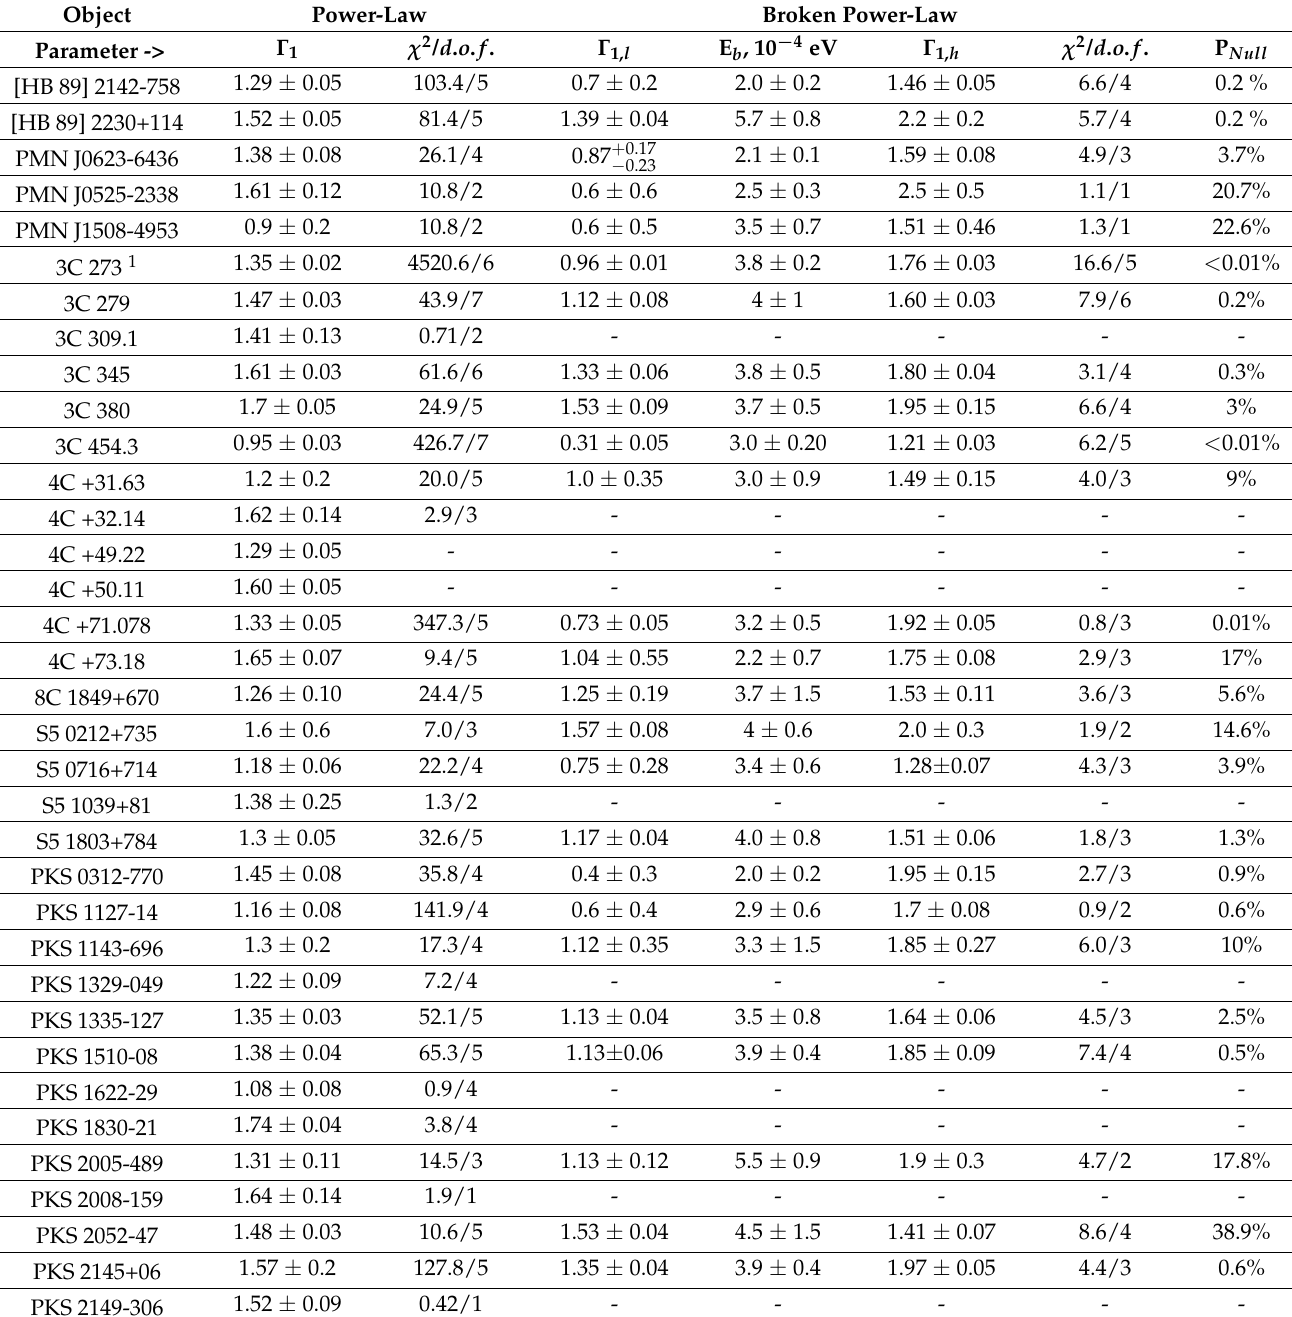
Table A1. The model parameters for the Planck